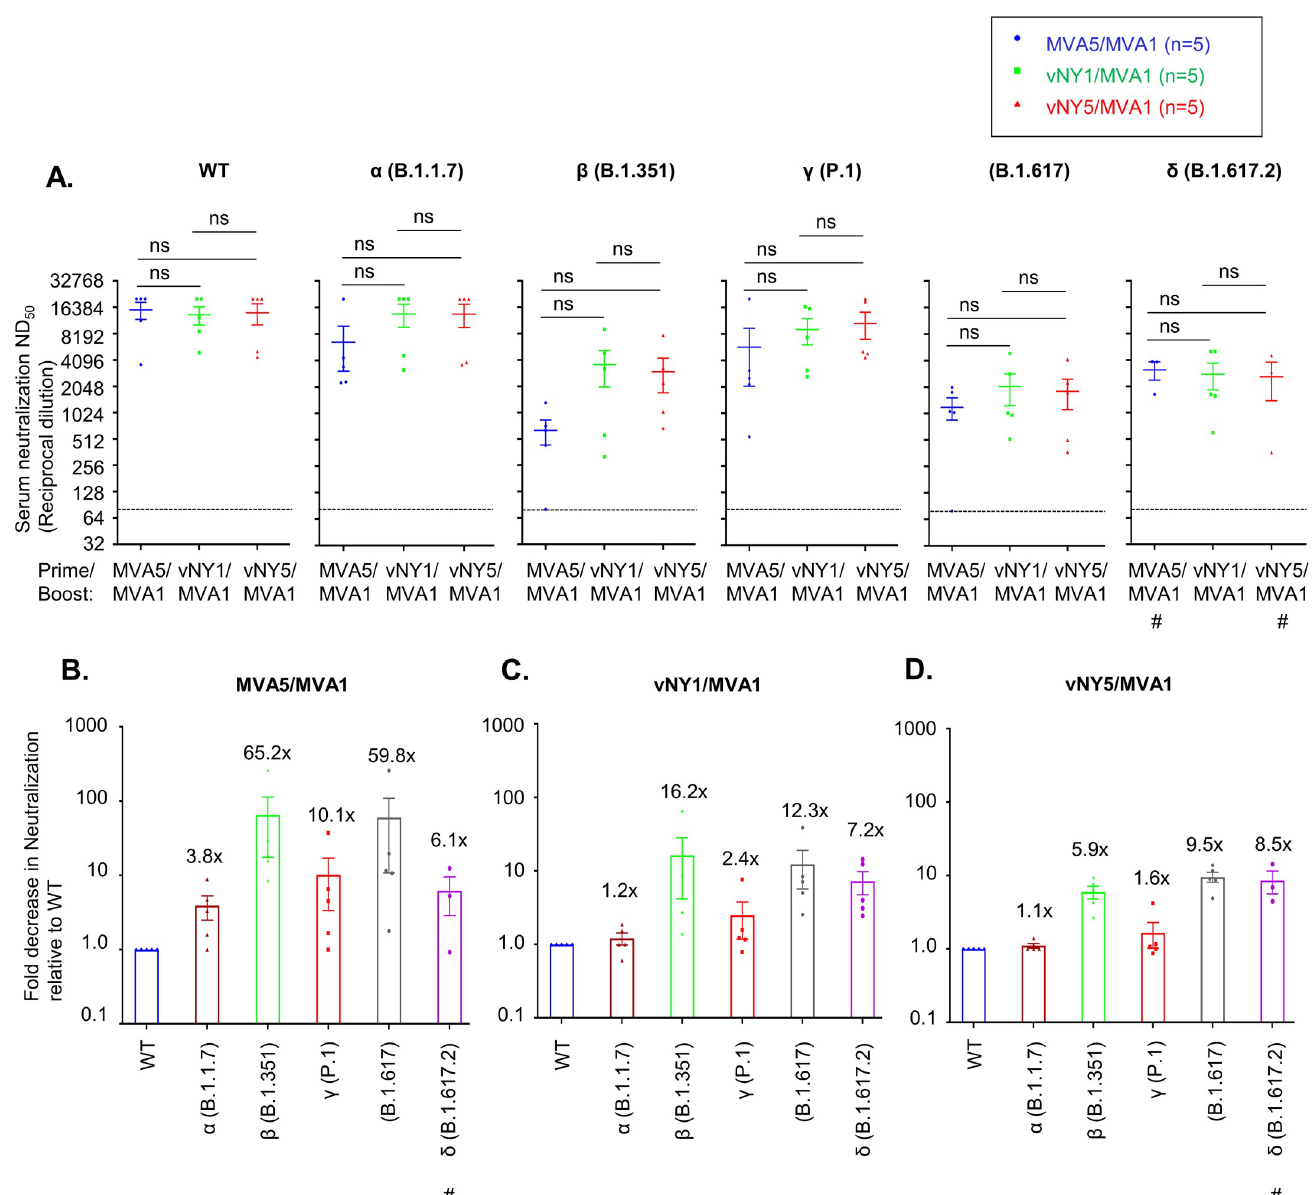
Fig 8. Sera from vaccinated mice partially cross-neutralized SARS-CoV-2 variants of concern. (A). Neutralization assays of secondary sera collected from vaccinated mice (regimens MVA5/MVA1, vNY1/MVA1 and vNY5/MVA1) following SARS-CoV-2 pseudotyped virus with spike protein from WT and variants α (B.1.17), β (B.1.351), γ (P.1), B1.617 and δ (B.1.617.2). The dotted line represents assay limit of detection. # represents n = 3. ns-not significant. (B-D). Fold decrease for immunized sera from MVA5/MVA1 (B), vNY1/MVA1(C) and vNY5/MVA1(D) vaccination regimens in neutralization assays of individual variants relative to WT pseudovirus. Fold change was calculated by dividing the ND 50 titer of each immunized serum against WT pseudovirus with the ND 50 titer of the same serum against variant pseudovirus. # represents n = 3. The dotted line represents assay limit of detection. Data are represented as mean ± SEM.